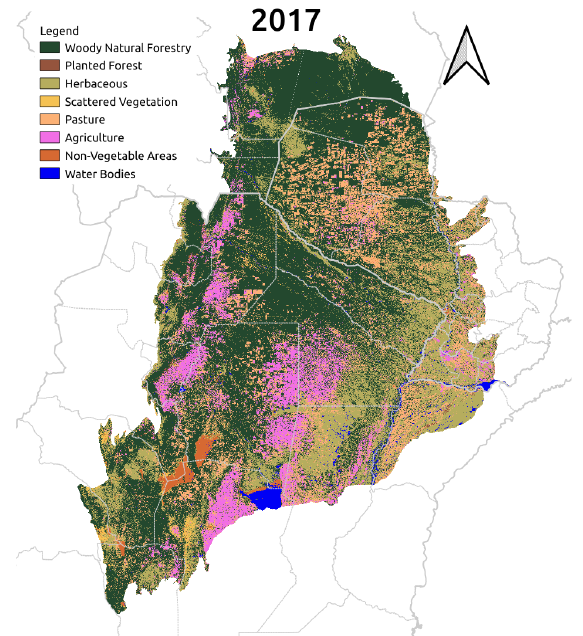
Figure 3. Map of the Gran Chaco for the last years 2017 of the period evaluated by this